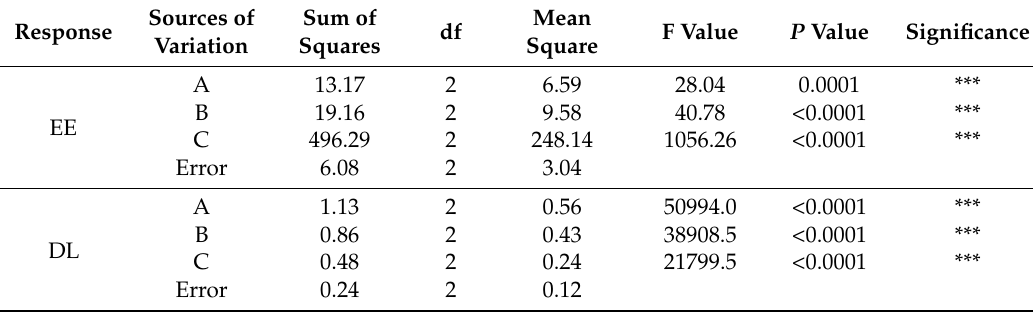
Table 3. Analysis in variance of the orthogonal experiment.